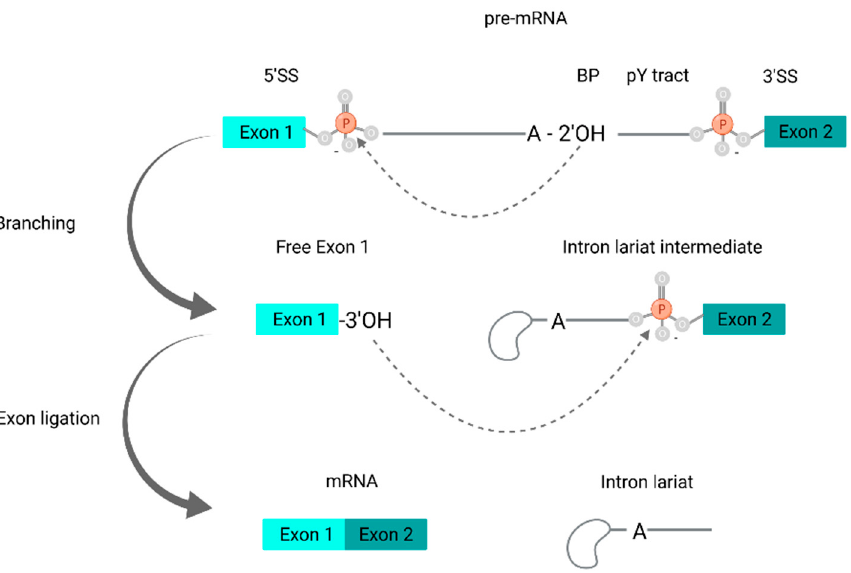
Figure 3. Two-step transesterification mechanism of pre-mRNA splicing. In the branching step, the 2 ′ -OH of the branch point (BP) adenine of exon 2 attacks the phosphate of the guanine at the 5 ′ end of the 5 ′ splice site (5 ′ SS) of exon 1. During exon ligation, the 3 ′ -OH of the free exon attacks the phosphate of the 5 ′ end of the intron lariat intermediate.